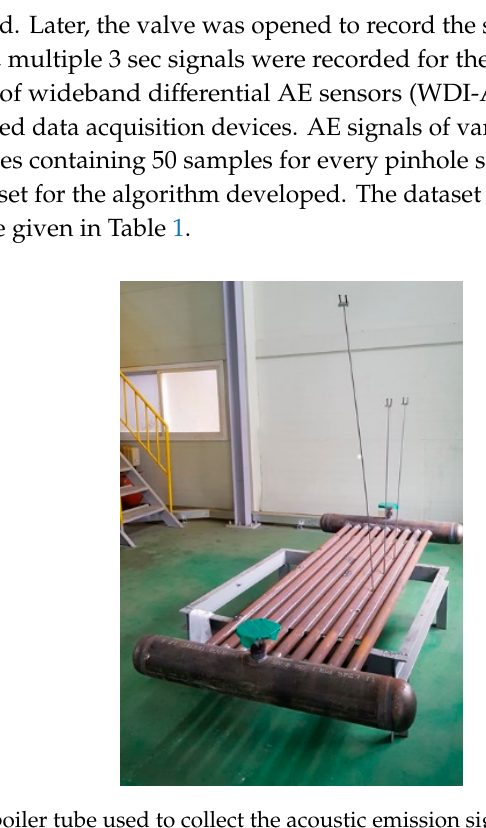
Figure 4. The boiler tube used to collect the acoustic emission signals for the experiment .